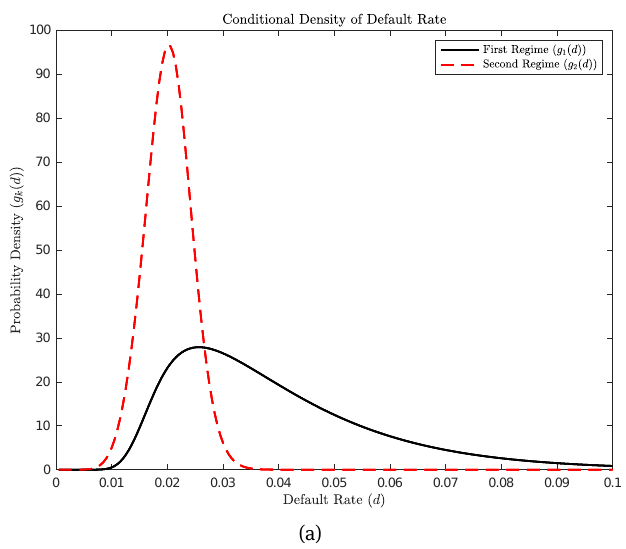
Figure 4.4: This figure illustrates the conditional density of the large-portfolio default rate in each regime, in the context of our numerical example. Specifically, it graphs g 1 (·) (the conditional density in the first regime, solid line) and g 2 (·) (the conditional density in the second regime, dashed-line), where the expression for g k (·) is given by (4.29) . We see that the first-regime den- sity is relatively more concentrated on large default